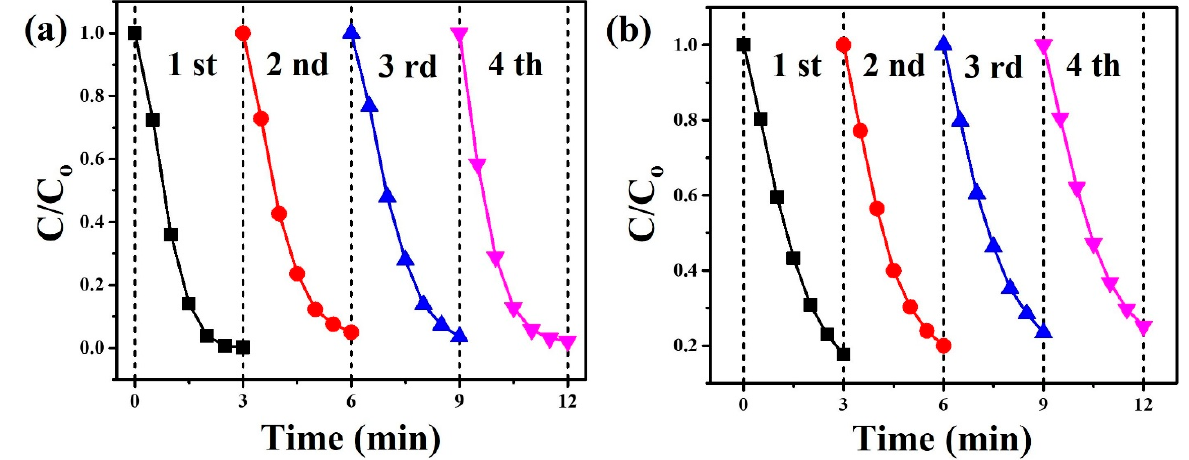
Figure 10. The reusability of the ZnO nanowalls (50 mM) for ( a ) MB and ( b ) TC solution under UVC light irradiation.